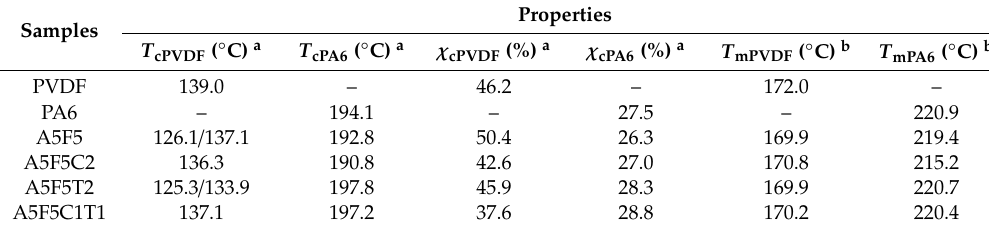
Figure 4. DSC curves of different samples at: ( a ) 5 °C/min cooling and ( b ) 40 °C/min cooling; DSC curves of PA6 isothermally crystallized at indicated T c in different samples: ( c ) A5F5 and ( d ) A5F5C2; ( e ) t p − 1 of PA6 as a function of T c for different samples. Table 3. Representative DSC thermal data of the samples.